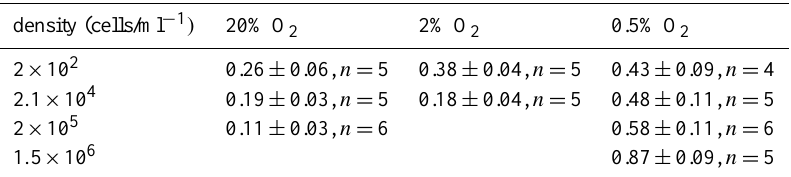
Table 4. The fraction of N 2 O produced by nitrifier-denitrification (F ND ) calculated using measured SP values, Eq. (4b), and the best fit values for SP ND and SP NH in Table 2 OH